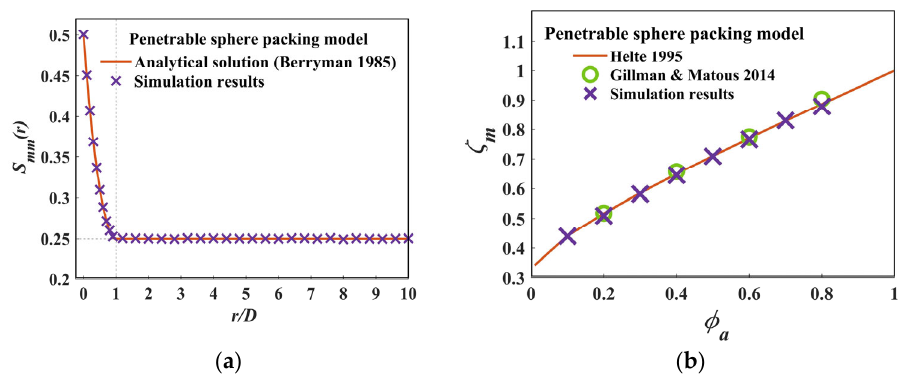
Figure 5. ( a ) Comparison of S mm in this work and analytical solutions [27]; ( b ) Comparison of ζ m in this work with existing results [20,21].